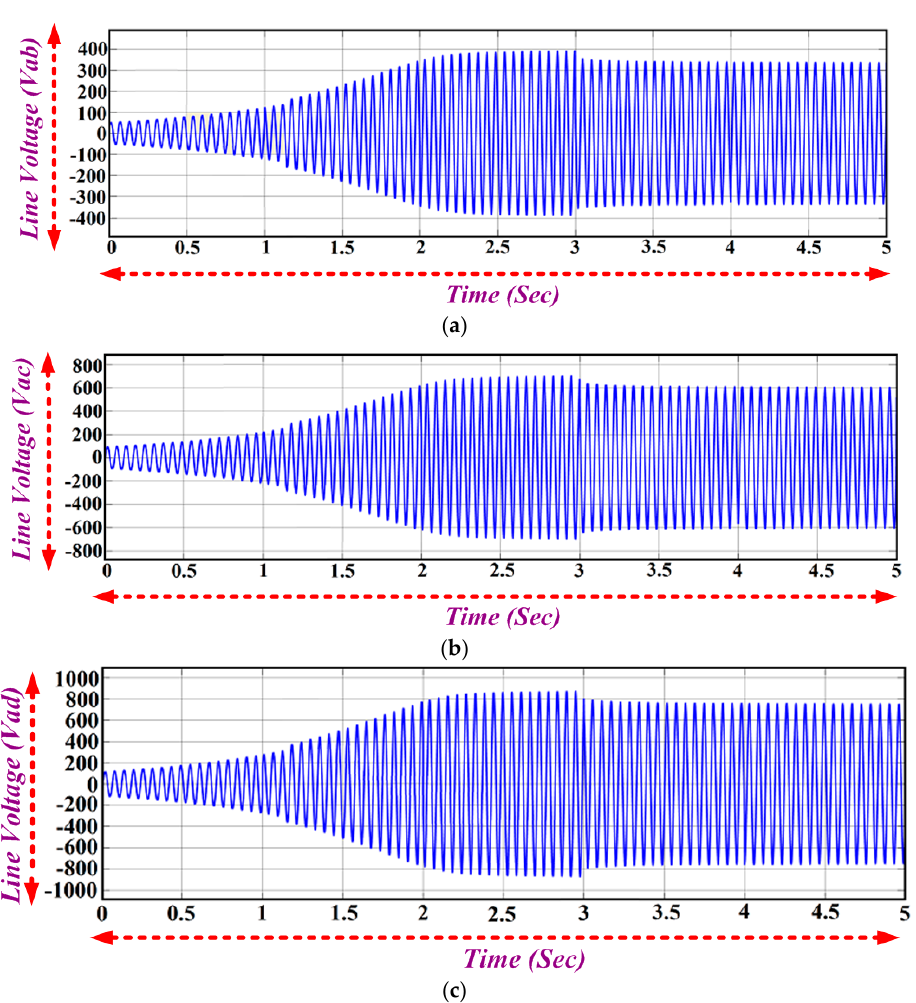
Figure 8. Generated Line Voltage of 7PIG Adjacent Side and Non Adjacent Side ( a ) V ab ; ( b ) V ac ; ( c ) V ad